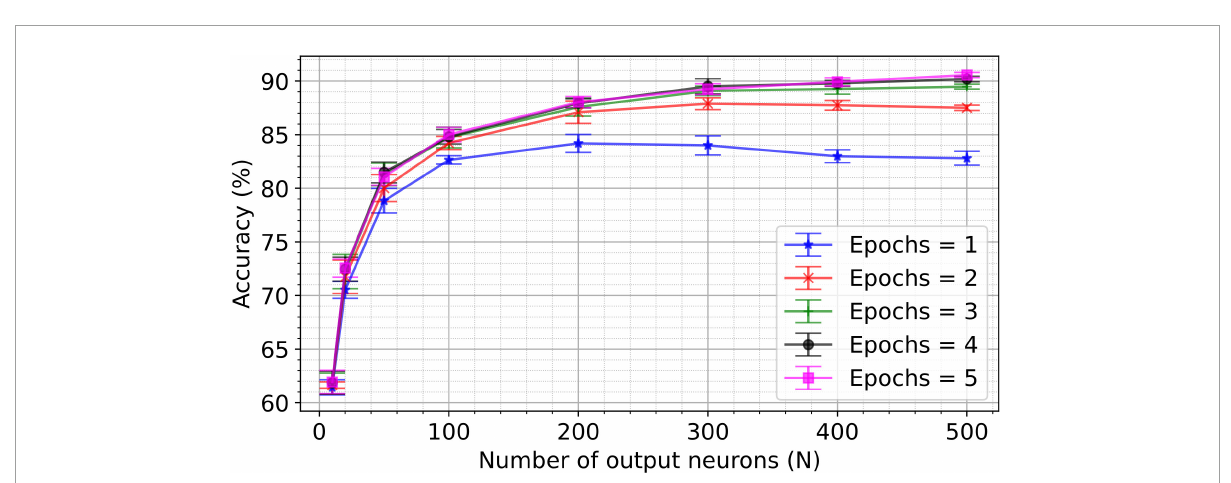
FIGURE5 A spiking neural network with 784 input neurons and N output neurons was trained on the training set (60,000 images) of the MNIST dataset for different numbers of epochs. The accuracy was computed on the test set (10,000) unseen images of the MNIST dataset. Networks with the number of output neurons ranging from 10 to 500 were trained for the number of epochs ranging from 1 to 5. Each experiment was conducted for five different initial conditions. The mean accuracy for five trials is plotted in the figure, with the error bar indicating the standard